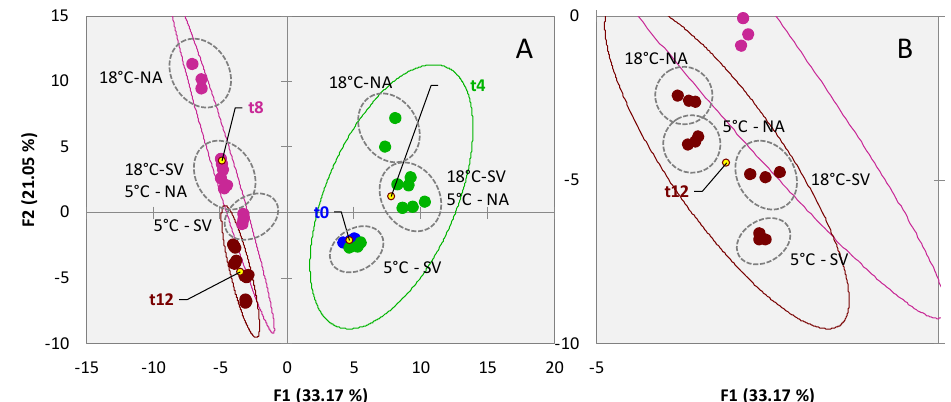
Figure 1. PCA scores plot based on normalized chromatographic areas from 95 targeted compounds across all analyzed walnut samples ( A ). Confidence ellipses (95% of confidence) relate to shelf-life (t0-blue; t4-green; t8-purple; t12-garnet color). In ( B ) the t12 samples are highlighted.